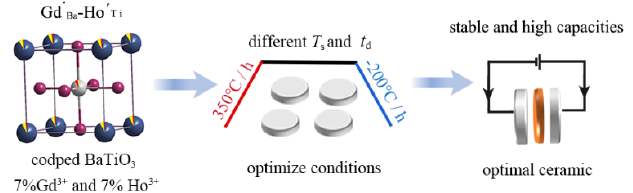
Figure 1. Target roadmap for high and stable capacitance